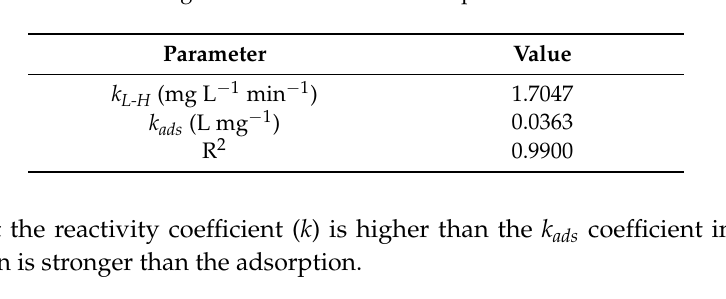
Table 3. Langmuir-Hinshelwood kinetic parameters for